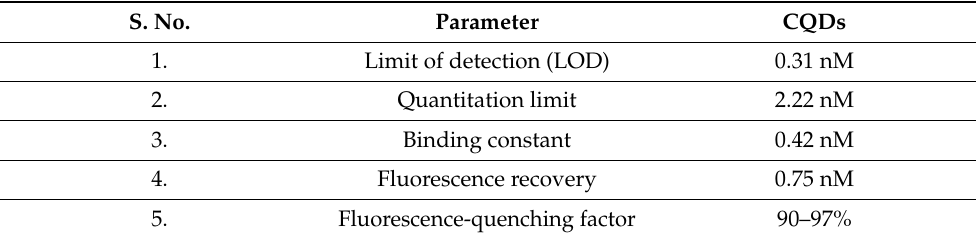
Figure 8. ( a ) Stern–Volmer plot and ( b ) B-H plot of CQDs in the presence of Cu 2+ ions. Table 1. The determined values of the detection limit, quantitation limit, binding constant, fluorescence recovery and quenching of synthesized C-dots.